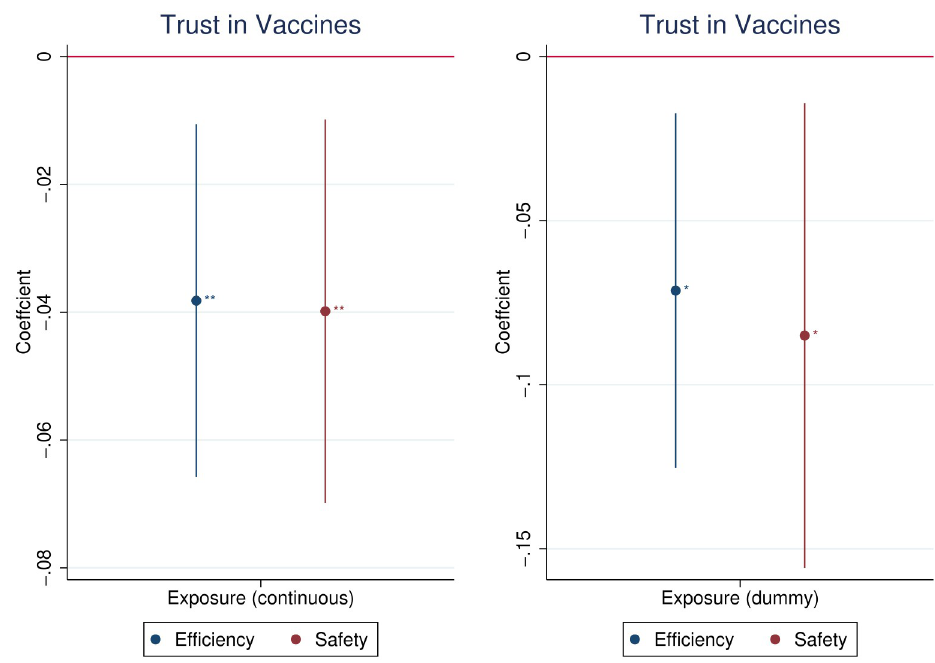
Fig 3. Effects of the exposure to Soviet communism on trust in vaccines’ efficiency and safety. Notes : The treatment variable is the length of exposure to Soviet communism in years smoothed with inverse hyperbolic sine function. Control variables: age fixed-effects, gender, country fixed-effects and country-specific time trend. Presented confidence intervals at 95% significance level are obtained using standard errors clustered by country.